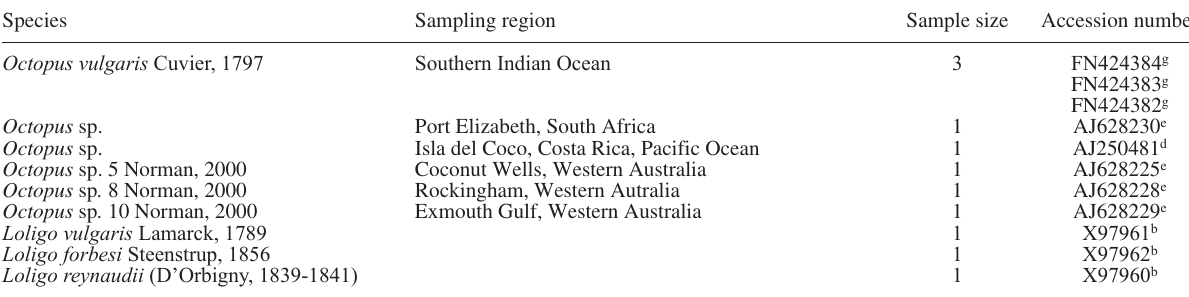
Table 1 (cont.). – Specimens, sampling regions, sample sizes and accession numbers of DNA sequences included in the phylogenetic infer- ences with COIII. Sequences reassigned to other genera by Norman and Hochberg (2005) that are still identified as Octopus in GenBank have their accession numbers underlined; specimens marked as “unplaced” are those of uncertain position but left in the genus until further revision by the same authors. Species used as outgroups are listed at the bottom of the table.